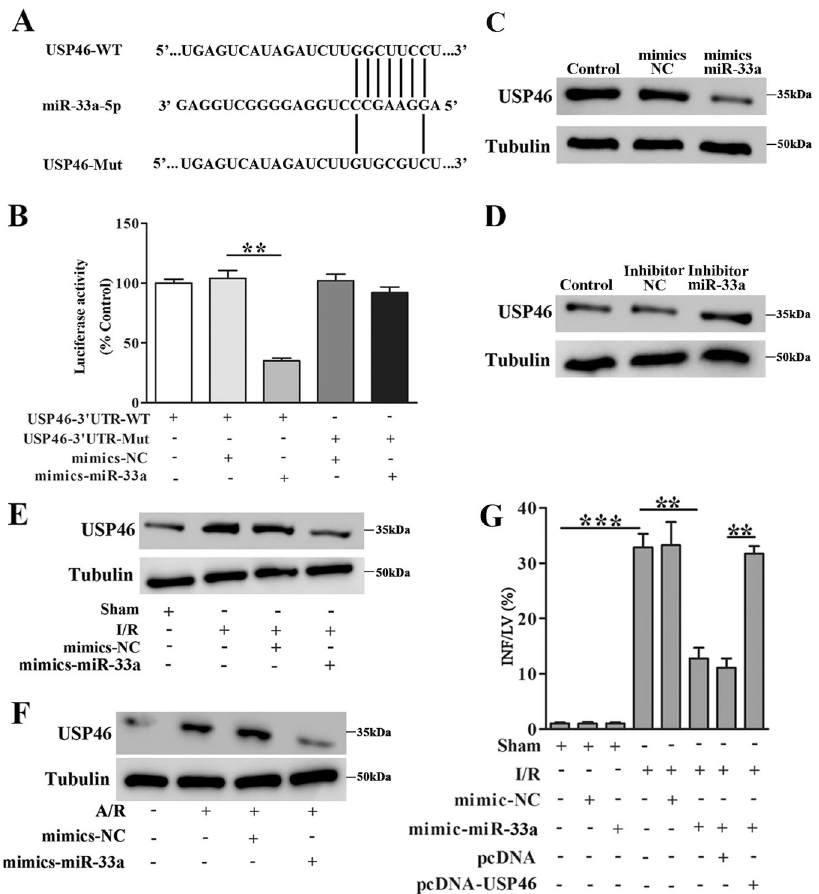
Fig. 6 MiR-33a-5p directly regulates USP46. A Sequences of USP46 3 ′ -UTR (USP46-WT) and a mutant USP46 3 ′ -UTR derivative (USP46-Mut) with mutations at the putative miR-33a-5p binding site are shown. B HEK293 cells were transfected with mimics-miR-33a-5p/mimics-NC along with the luciferase construct carrying USP46-WT or USP46-Mut as indicated. The luciferase activity was detected after 48 h transfection, n = 3. C , D USP46 expression was determined by western blot analysis. Cardiomyocytes were transfected with mimics-miR-33a-5p/mimics-NC ( C ) or inhibitor-miR-33a-5p/inhibitor-NC ( D ). E Mice received mimics-miR-33a-5p or mimics-NC by injection as described in methods, and were subsequently subjected to myocardial I/R (45 min/180 min). USP46 levels in cardiac tissues were determined by western blot analysis. F Cardiomyocytes transfected with mimics-miR-33a-5p or mimics-NC were subjected to A/R (30 min/60 min). USP46 levels were determined by western blot analysis. G Mice received mimics-miR-33a-5p or mimics-NC as described in methods and subsequently subjected to myocardial I/ R (45 min/180 min). Infarct size (% of risk zone) is shown, n = 6. ** P < 0.01, *** P <